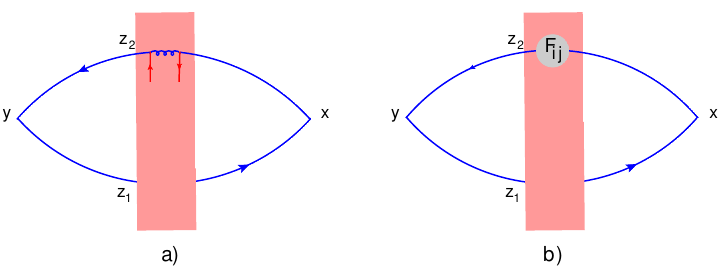
Figure 3 . Diagram of the LO impact factor with quark-sub-eikonal